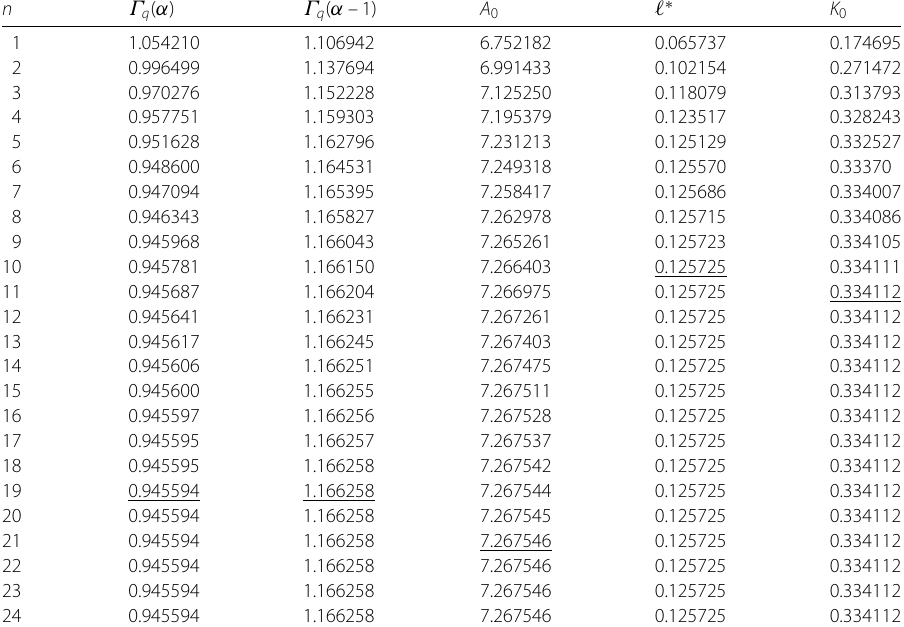
Table 4 Some numerical results for calculation of Γ q ( α ), Γ q ( α – 1), A , M and K in Theorem 5 with and m = q = 1 3